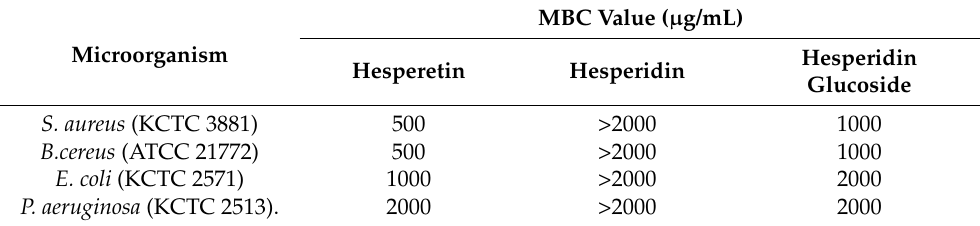
Table 3. Minimal bacteriocidal concentration (MBC) of hesperetin, hesperidin and hesperidin glucoside.